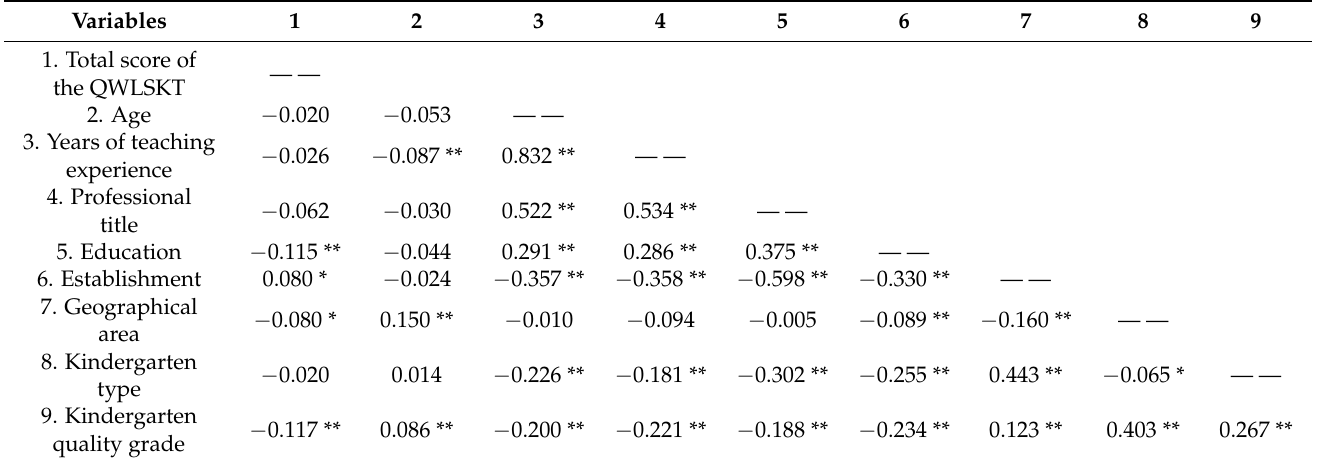
Table 6. Correlation analysis between contributors and the quality of work life scale for kindergarten teachers (QWLSKT).